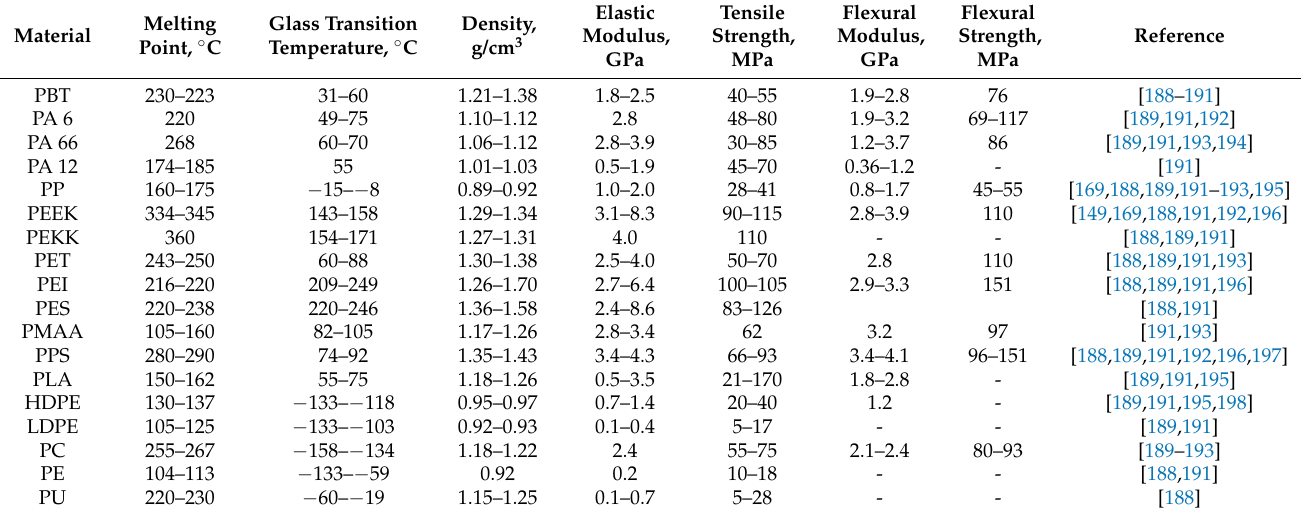
Table 1. Polymers used as a matrix in thermoplastic pultrusion.